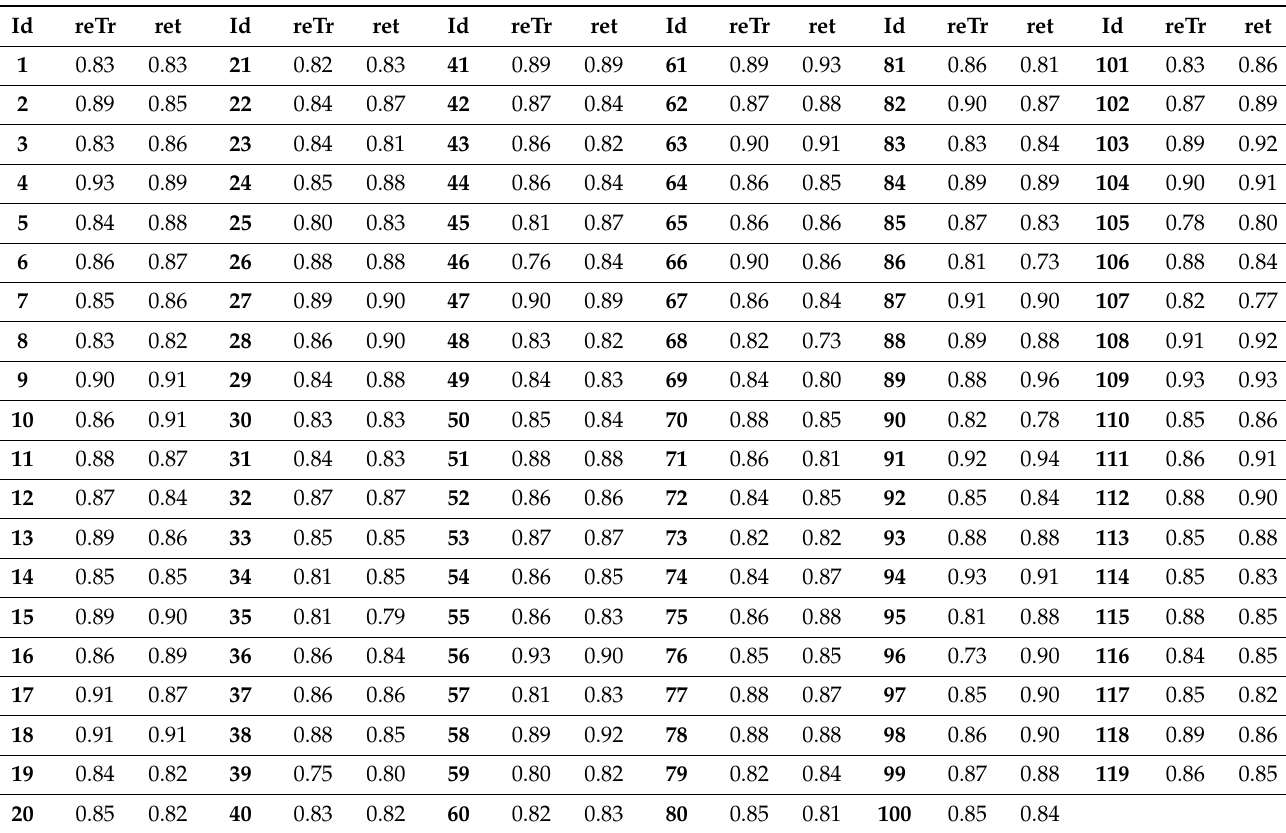
Table 4. Assessment of the relative error for the training (reTr) and for the testing (ret), for each weather station identified by the id code